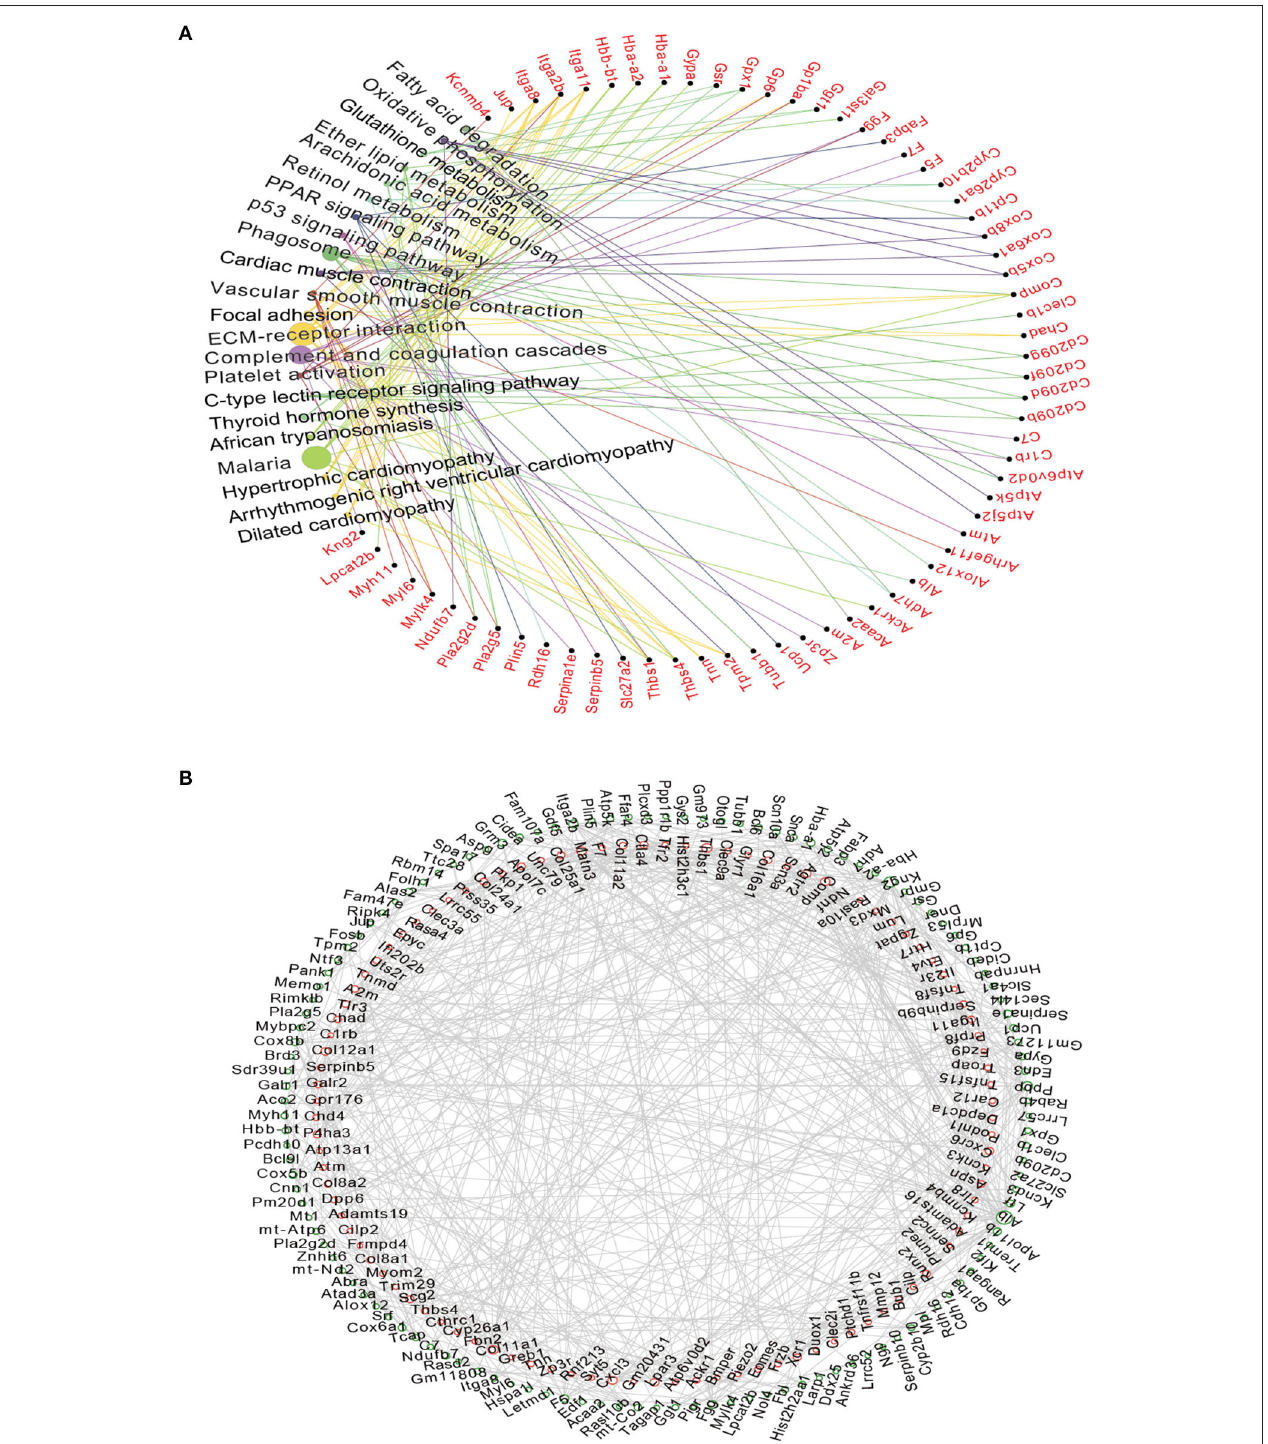
FIGURE 4 | The Network analysis of DEGs and predicted PPI networks in the TAC group. (A) KEGG analysis suggested that differentially mRNAs were mainly targeted to the ECM-receptor interaction and Complement and coagulation cascades. Circle size represented degree; (B) The network showed the potential relationship between the top 200 differentially up-regulated and down-regulated expressed mRNAs, Up-regulated mRNAs are displayed in the red circle, down-regulated in the green circle.